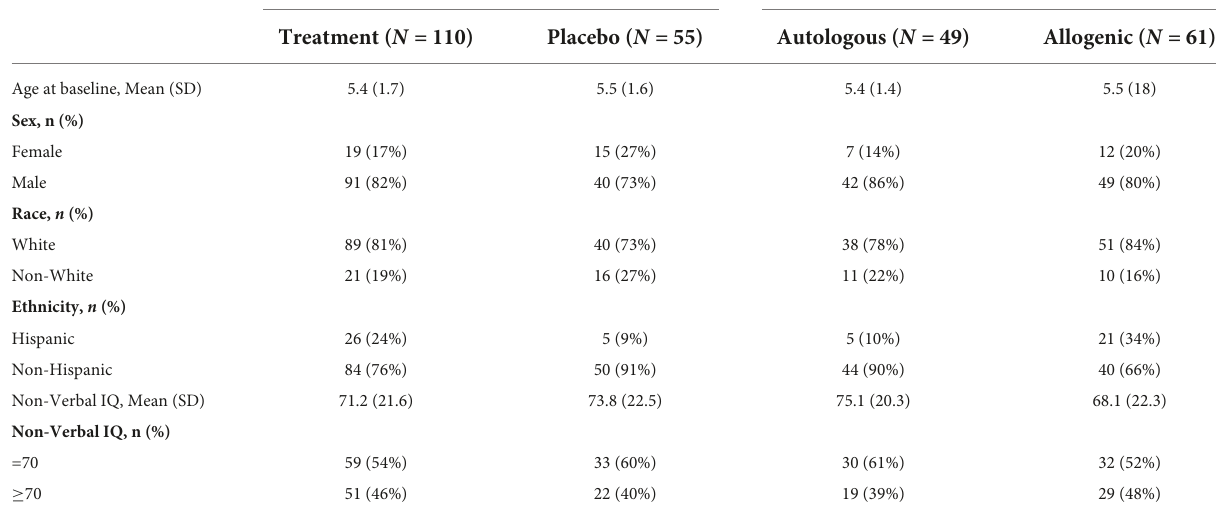
TABLE 1 Demographic characteristics of sample ( N =